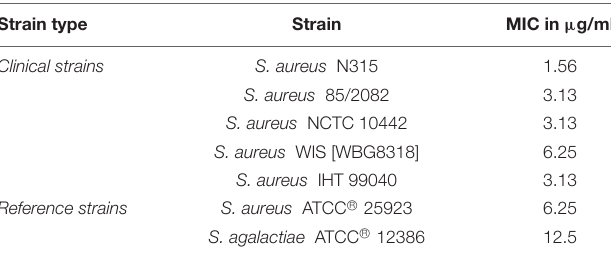
TABLE 2 | Minimal inhibitory concentrations (MICs) of 1 against reference strains and clinical isolates.